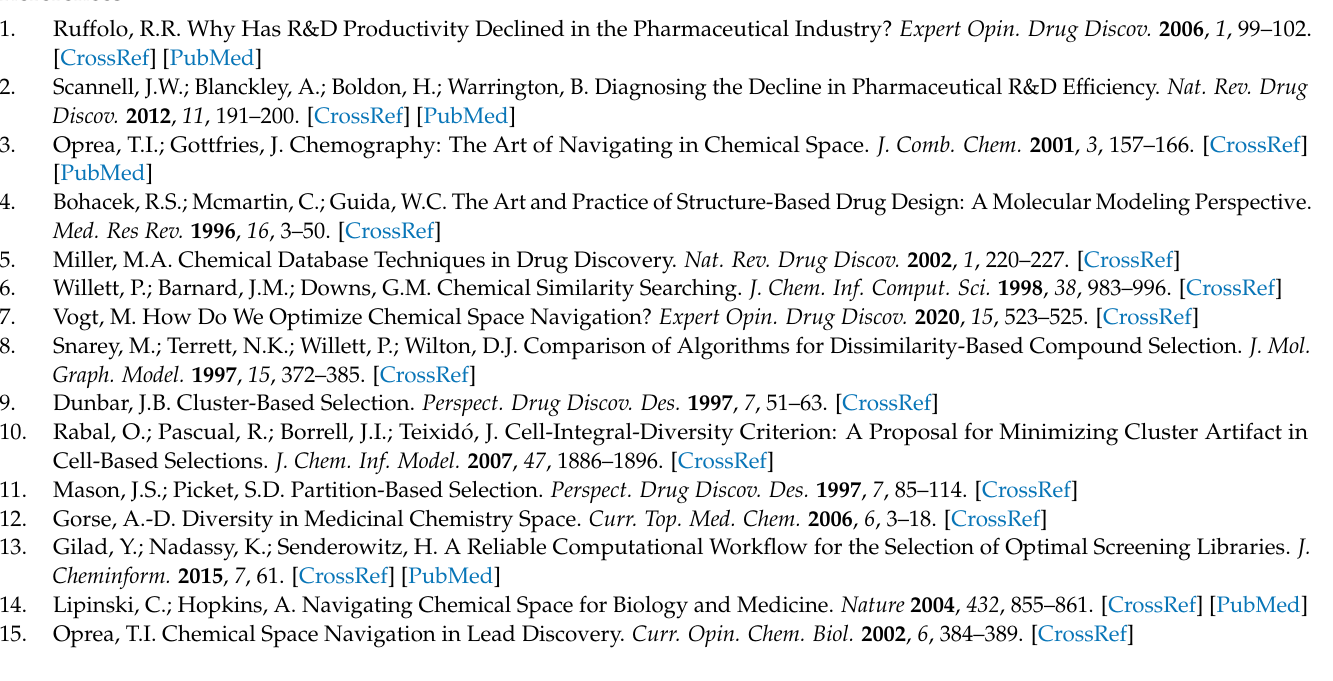
Table S3: Tafenoquine fragment library (25,472 analogues); Table S4: Ertugliflozin fragment library (14,194 analogues); Table S5: Rufinamide fragment library (8959 analogues); Table S6: Azilsartan Me- doxomil fragment library (1110 analogues); Table S7: Leflunomide fragment library (5641 analogues); √ N ); Table S9: SC and PC for Abemaciclib Table S8: SC and PC for Dacomitinib analogues ( k = √ √ N ); Table S10: SC and PC for Tafenoquine analogues ( k = N ); Table S11: SC analogues ( k = √ N ); Table S12: SC and PC for Rufinamide analogues and PC for Ertugliflozin analogues ( k = √ √ N ); Table S13: SC and PC for Azilsartan Medoxomil analogues ( k = N ); Table S14: SC and ( k = √ N ); Table S15: List of 206 1D and 2D descriptors calculated PC for Leflunomide analogues ( k = using